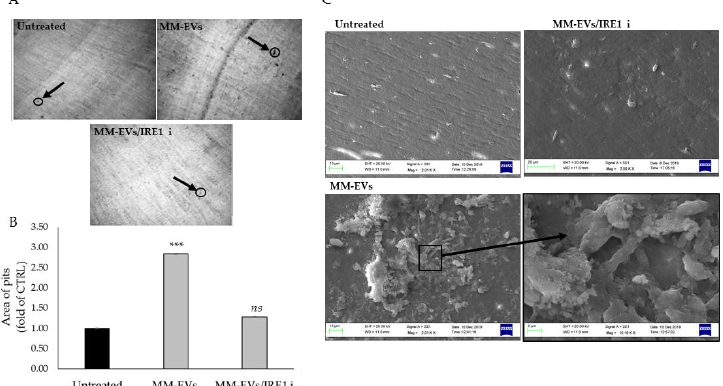
Figure 5. ( A ). Bone resorption pit assay of Raw264.7 cells seeded on dentine discs untreated or treated for 6 days with 25 μg/mL of MM-EVs alone or in co-treatment with IRE1 . Representative pictures of lacunae (dark areas) formed by cells (original magnification 10X) are reported. Black arrows are added to indicate some resorption pits. ( B ). Data relative to the resorbed areas by mature OCs, after 6 days of treatment with 25 μg/mL of MM-EVs or co-treated with MM-EVs and IRE1 , are represented as fold increase of Raw264.7 untreated cells. Three fields of each dentin disc for each experimental point were scored in three independent experiments. The area of the pits was calculated by NIH image J software analysis (htttp:/rsbweb.nih.gov/ij/). The statistical significance of the differences was analyzed using a Dunnett’s test (treated Groups vs. Untreated Group) (*** p -value < 0.0005, ns not significant). ( C ) Representative pictures of lacunae formed by OCs through SEM analysis (images at 1.10 K× and 2.01 K× magnification).